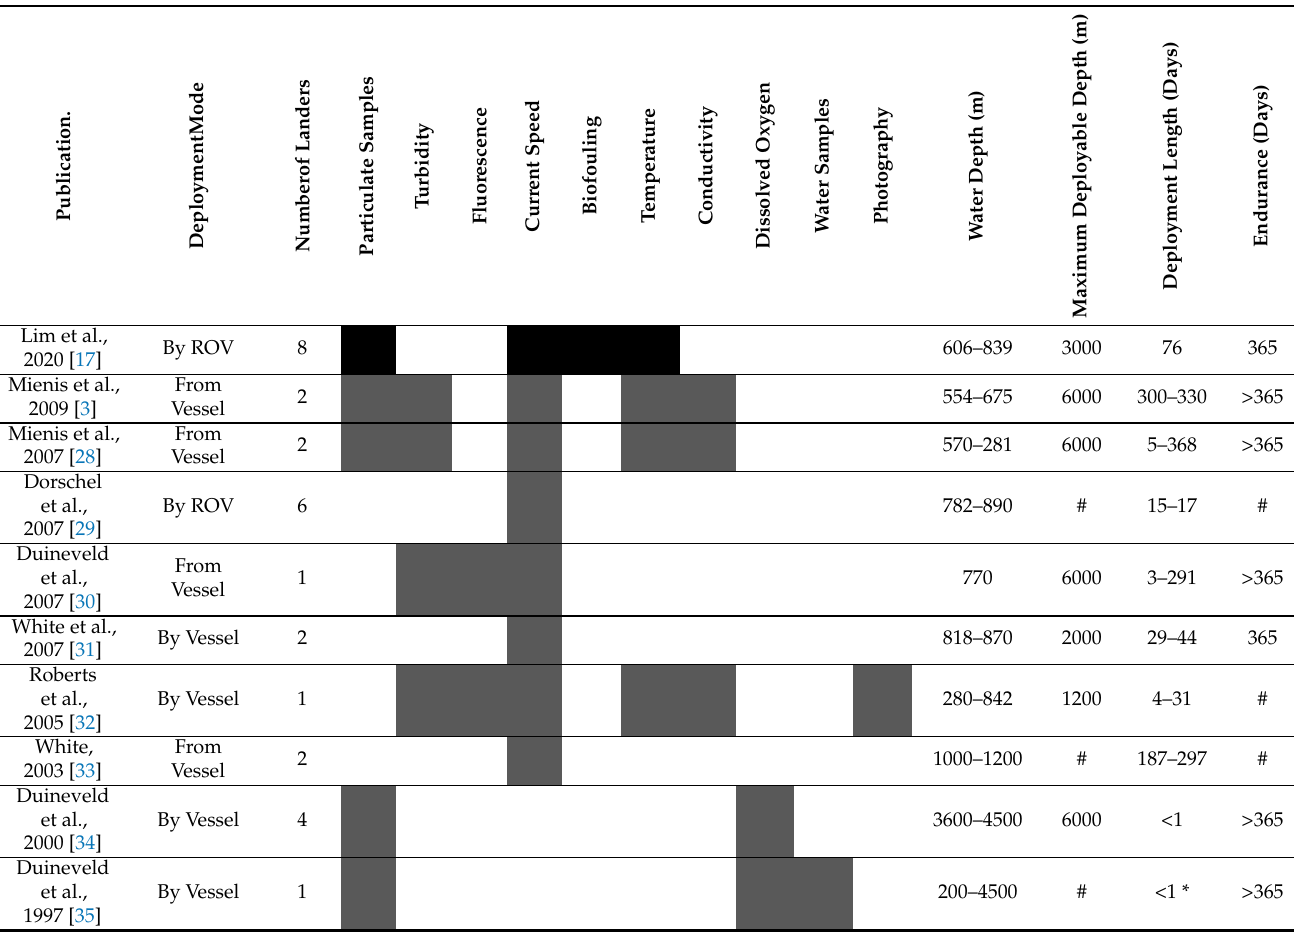
Table 1. Comparison of lander deployments on the Irish continental margin. The Little MonSta deployment is by Lim et al., 2020 [17].